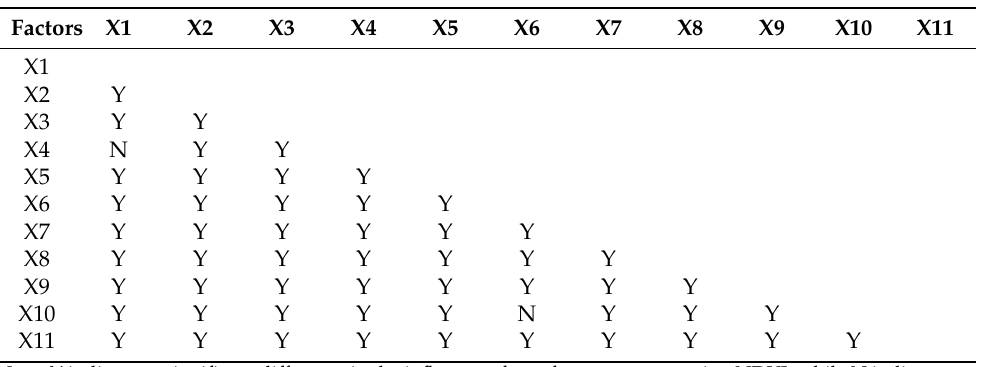
Table 6. Ecological detection of